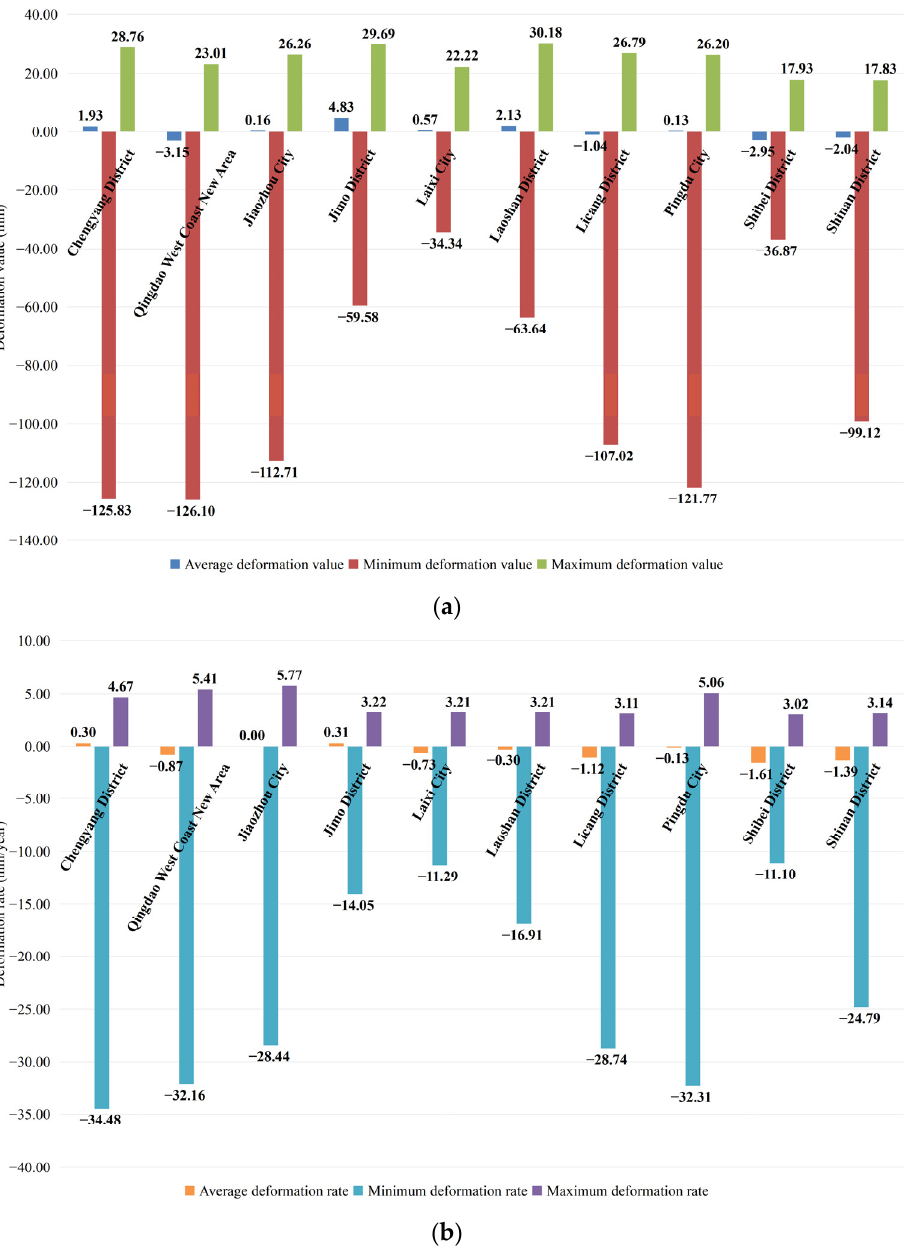
Figure 6. Statistical figures of the deformation rates and cumulative deformation values of the dis- tricts/cities in Qingdao: ( a ) deformation rate and ( b ) deformation value.